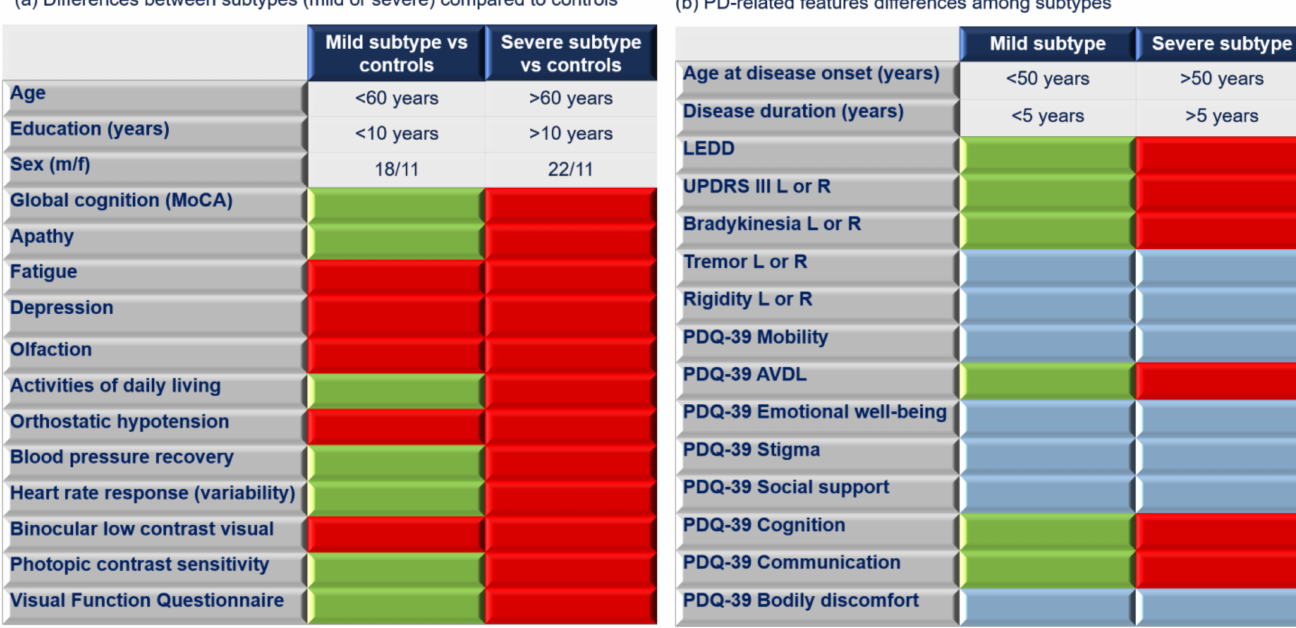
Figure 2. Demographic, nonmotor, and PD-related features of subtypes. ( a ) Graphical representation of demographic and nonmotor differences between the two identified clusters compared to controls. Red color indicates significantly ( p < 0.05) lower scores compared to controls; green color indicates